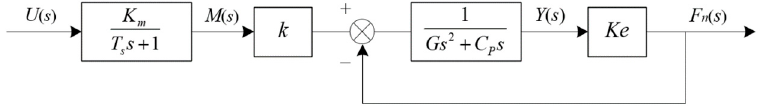
Figure 3. The transfer function block diagram of the end-effector